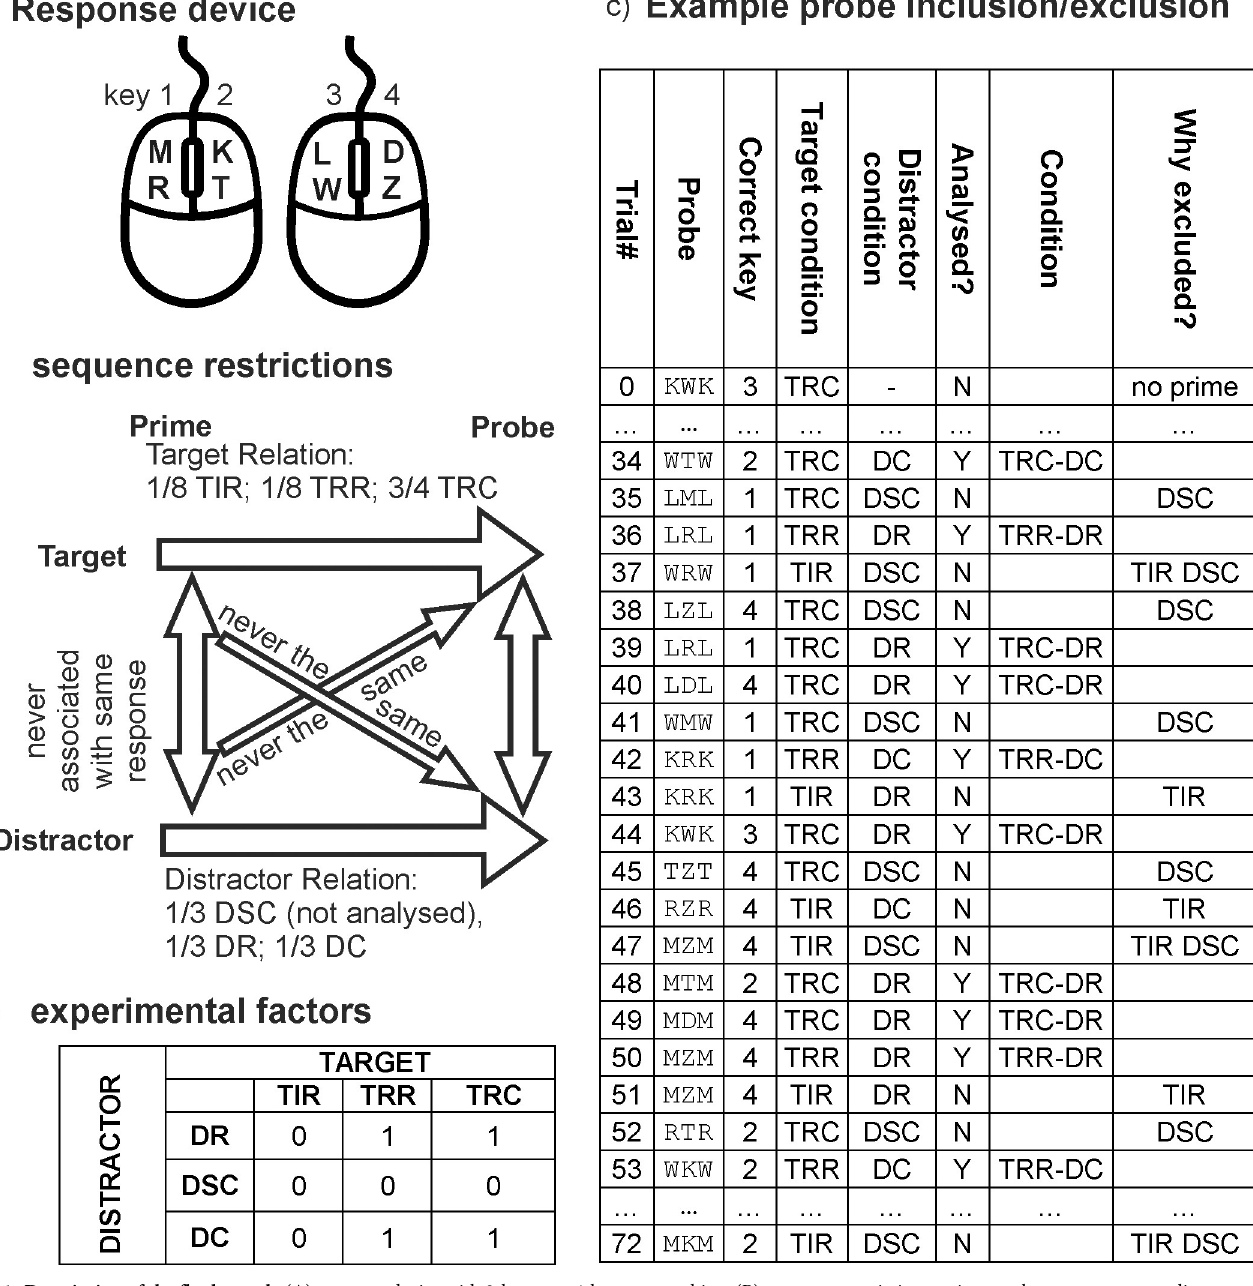
(= TRC; Target response change). Third, we balanced prime-probe distractor relation orthog- onally to target relation. In 1/3 of all trials, the probe distractor was an exact repetition of the